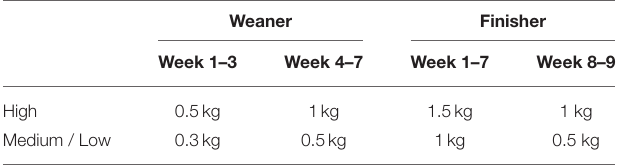
TABLE 1 | List of enrichment items provided for all pigs during the weaner and finisher stage.